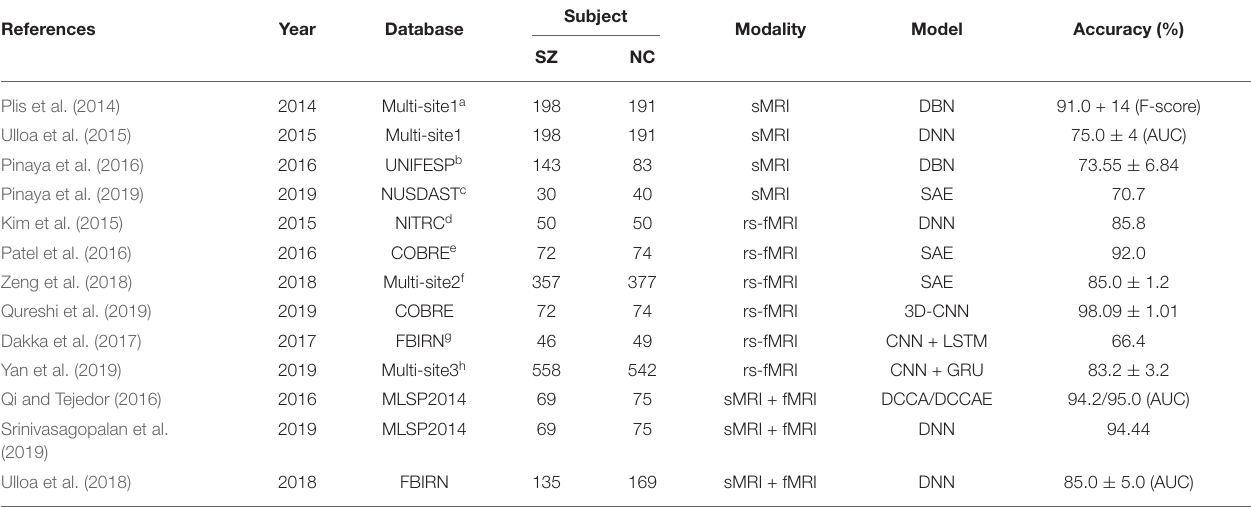
TABLE 7 | Overview of papers using deep learning techniques for SZ